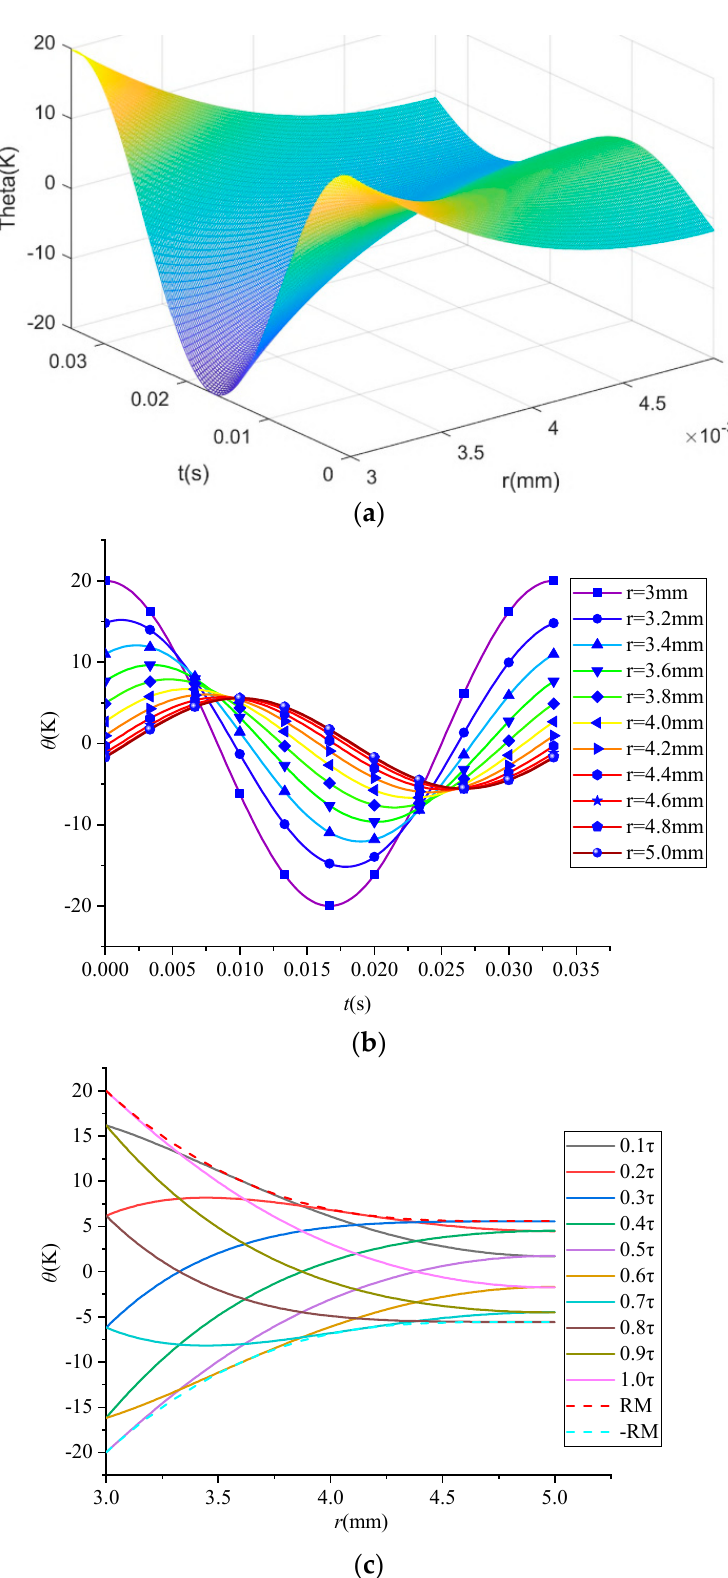
Figure 5. Amplitude curve with time and radius ( a ) three–dimensional amplitude–time–radius ( θ – t – r ) panorama of a period ( b ) θ – r diagram ( c ) θ – t diagram.